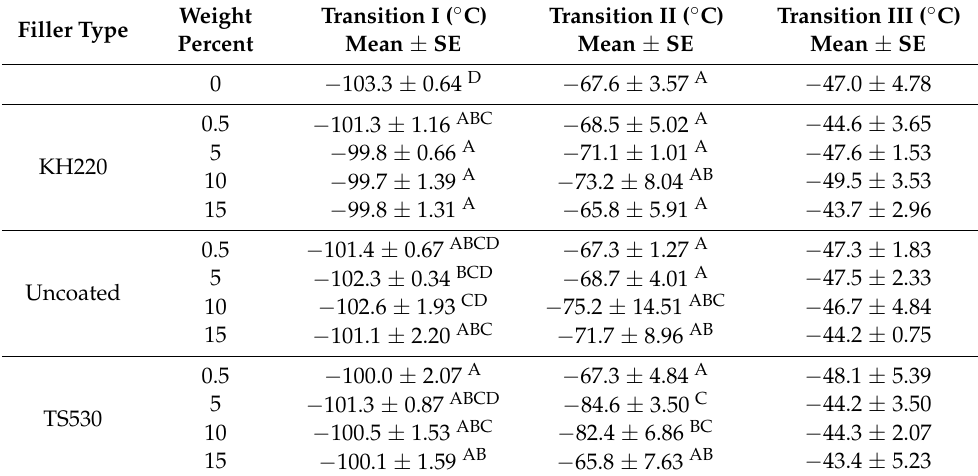
Table 3. Mean ± SE of Transition I, II, and III Temperatures. Results From ANOVA/Tukey *. Filler